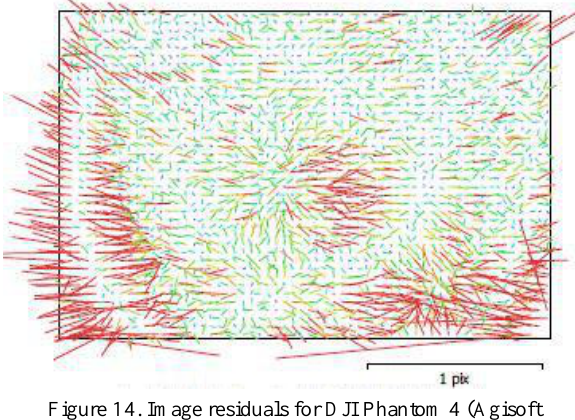
Figure 14. Image residuals for DJI Phantom 4 (Agisoft Metashape)